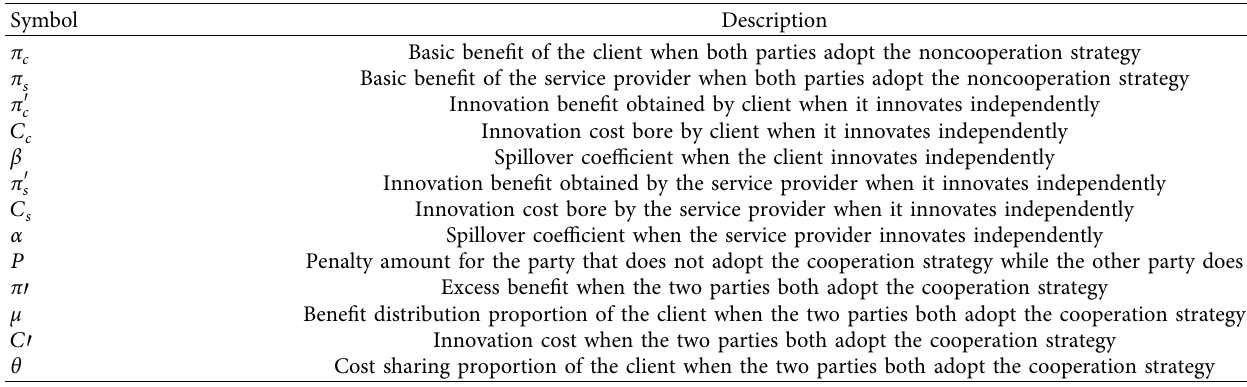
Table 2: List of